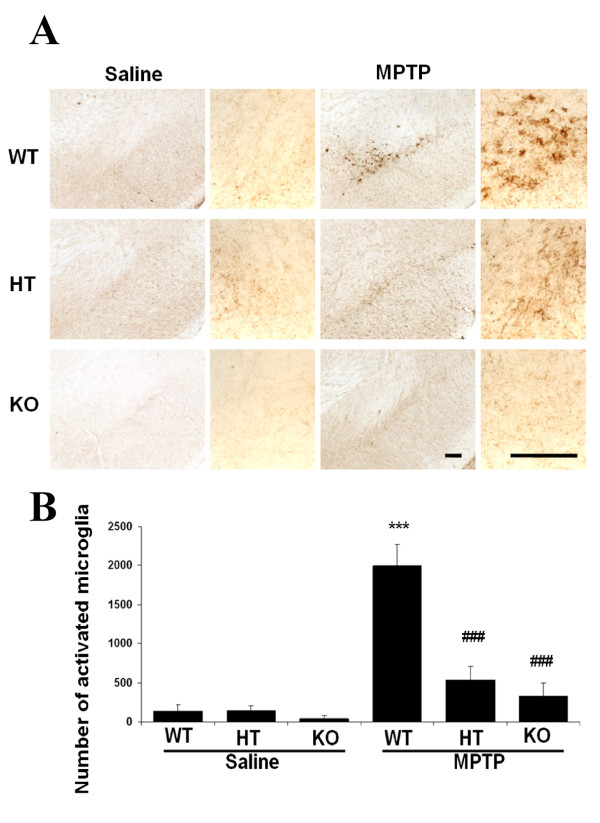
Ablation of COX-2 reduces MPTP-induced microglial activation 7 days post-MPTP injection. A: Seven days after MPTP treatment, COX-2 +/+ mice had a local increase of microglial activation in the SNpc, which is shown with immunohistochemical stains for Mac-1, compared to saline-treated or MPTP-treated COX-2 +/- and -/- mice. The magnified right panels show activated microglia. In contrast to inactivated striped microglia in MPTP-treated COX-2-deficient and control saline sections, activated microglia in MPTP-treated COX-2 wild-type have a rounder body, fatter processes and denser stain. B: MPTP treatment leads to a significant increase in the number of activated microglia in the WT relative to the HT and KO mice. Activated microglia in the SNpc were bilaterally counted under a 40 × objective. Data are means ± SEM for six to eight mice per group, ***p < 0.001 compared to saline+vehicle group; ###p < 0.001 compared to MPTP+vehicle group, by ANOVA with subsequent Bonferroni for multiple comparisons. Scale bar, 100 μm.